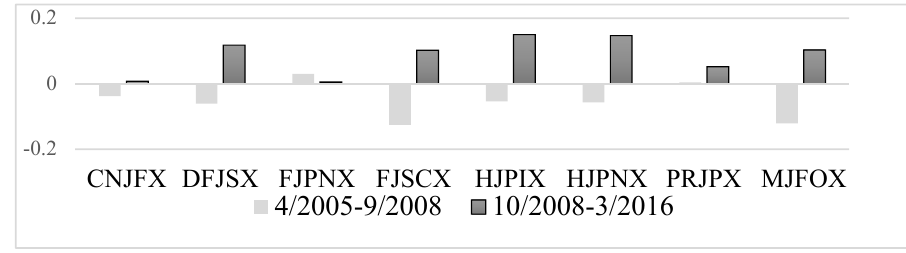
Figure 5. Alpha/beta (in absolute values); benchmark: TOPIX.